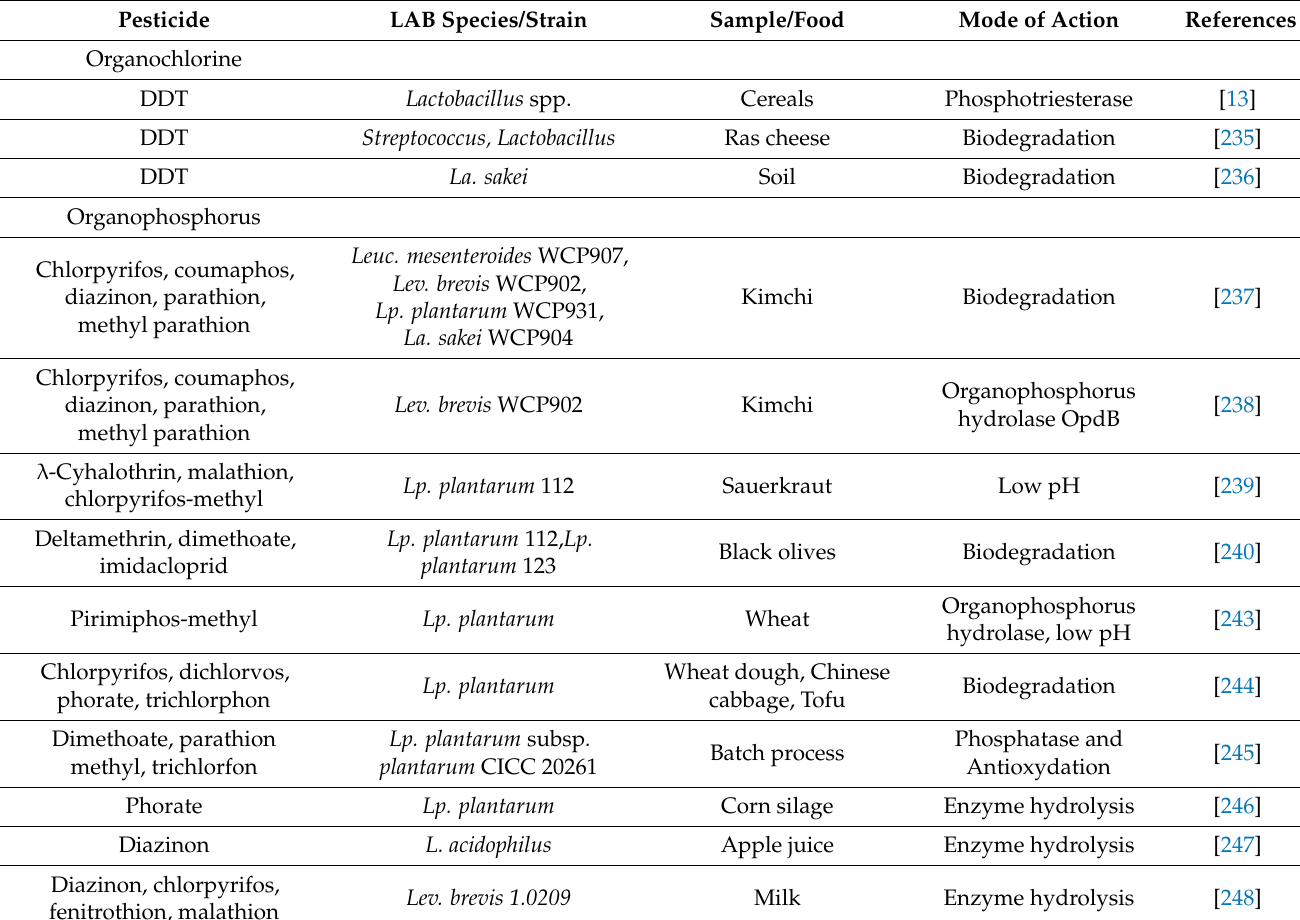
Table 7. Detoxification of pesticides falling in food content by lactic acid bacteria